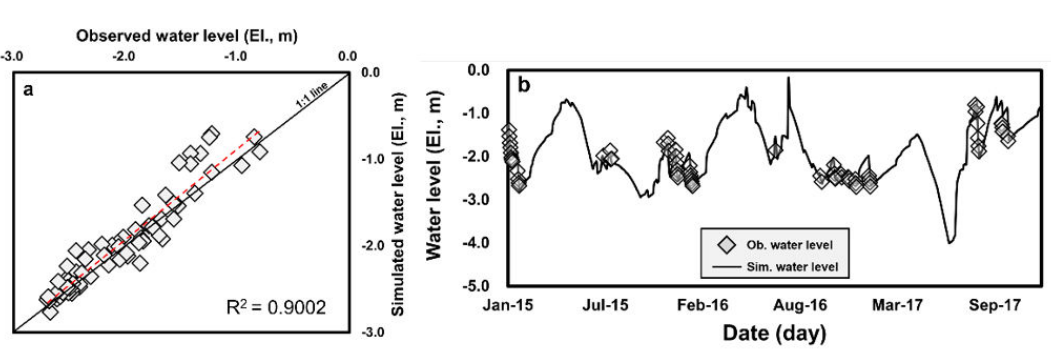
Figure 5. ( a ) A comparison of the observed and simulated water levels and ( b ) changes to the water level elevation in the estuarine reservoir (2015–2017)